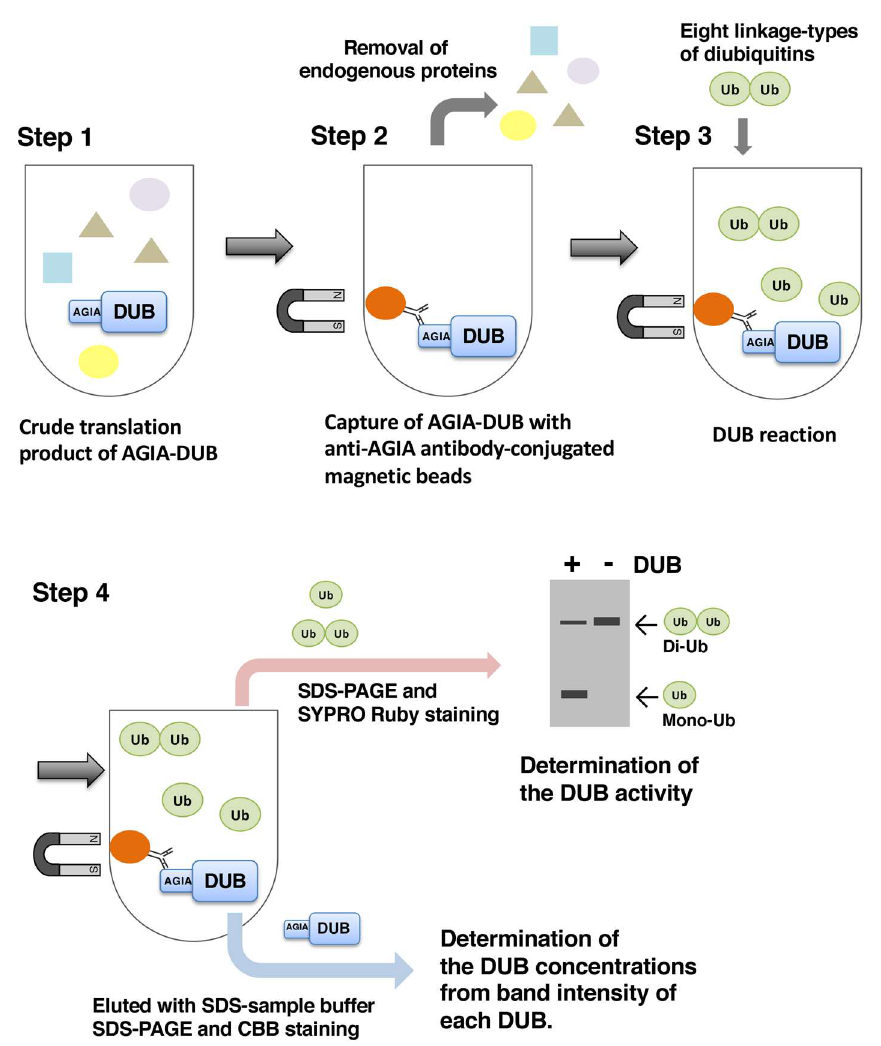
Figure 1. Overview of the in vitro DUB assay using eight linkage types of diubiquitin.